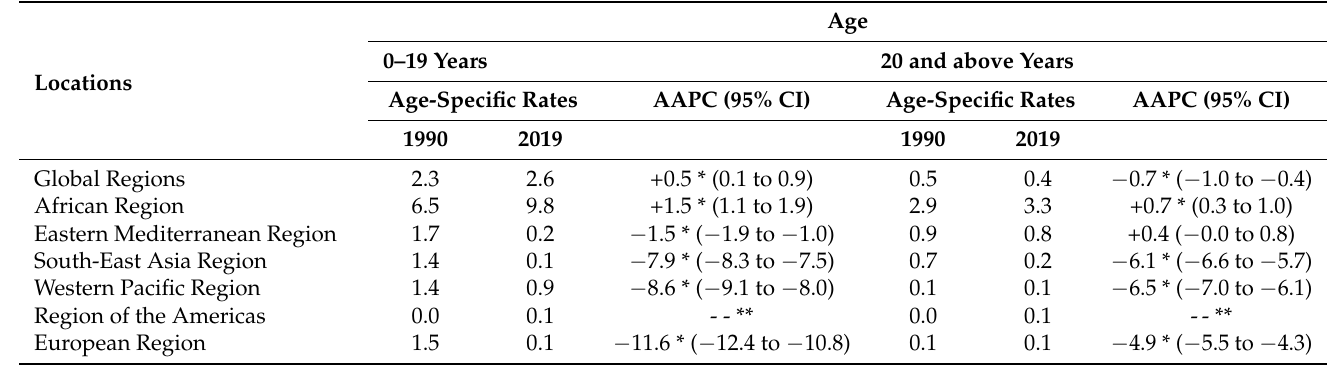
Table 2. Joinpoint regression analysis: Global trends in mortality rates of cholera in both sexes (per 100,000 population), by age (age strata: 0–19 and 20 and above years), and by regions of World Health Organization,